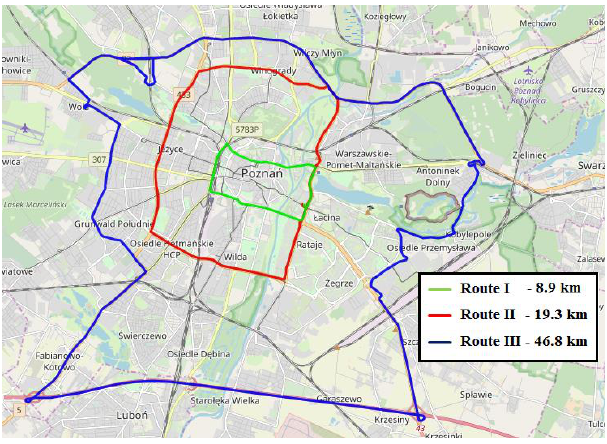
Fig. 4. Test routes in the Poznan